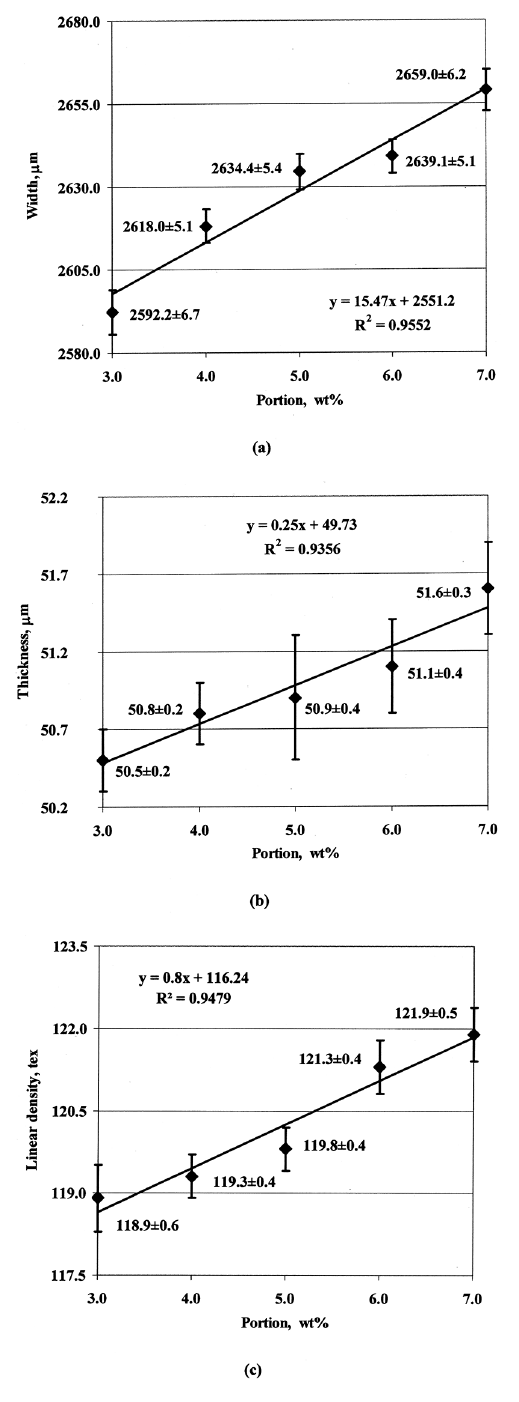
Figure 5: Effect of portion of additive Granic 422 on macro-structure of tapes: a – width, b –thickness, c – linear